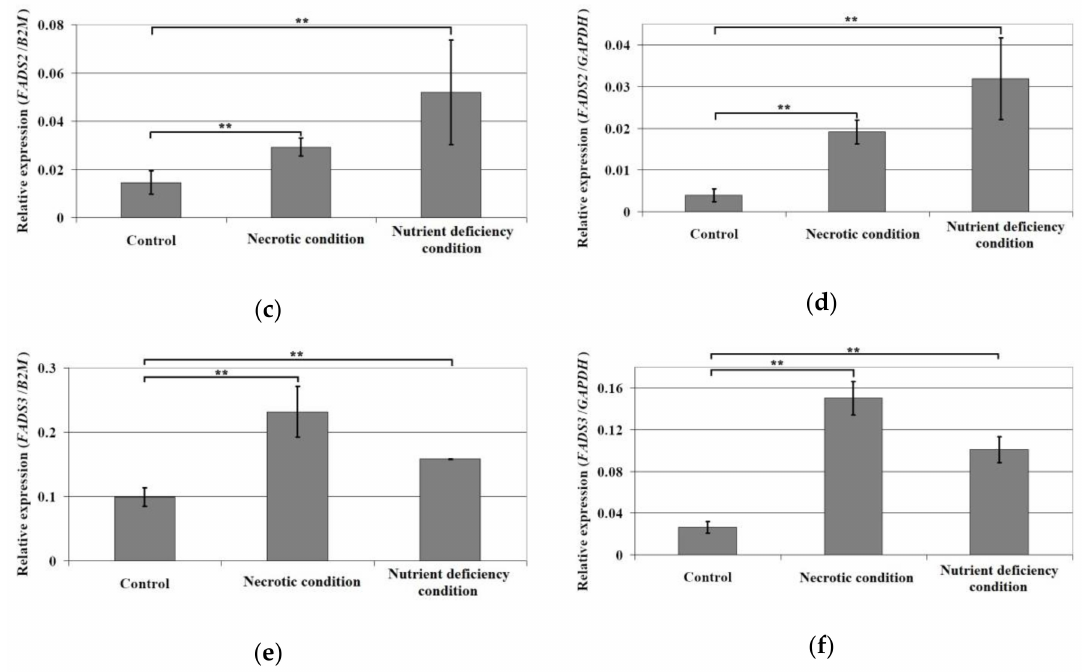
Figure 7. E ff ect of the necrotic condition or nutritional deficiency on the mRNA expression of FADS1 ( a , b ), FADS2 ( c , d ), and FADS3 ( e , f ). Human brain (glioblastoma astrocytoma) U-87 MG cell line cultured in EMEM medium with 10% FBS, 2 mM l -glutamine, 1 mM sodium pyruvate, 1% non-essential amino acids, 100 U / mL penicillin, and 100 µ g / mL streptomycin. U-87 MG cells were seeded in 6-well